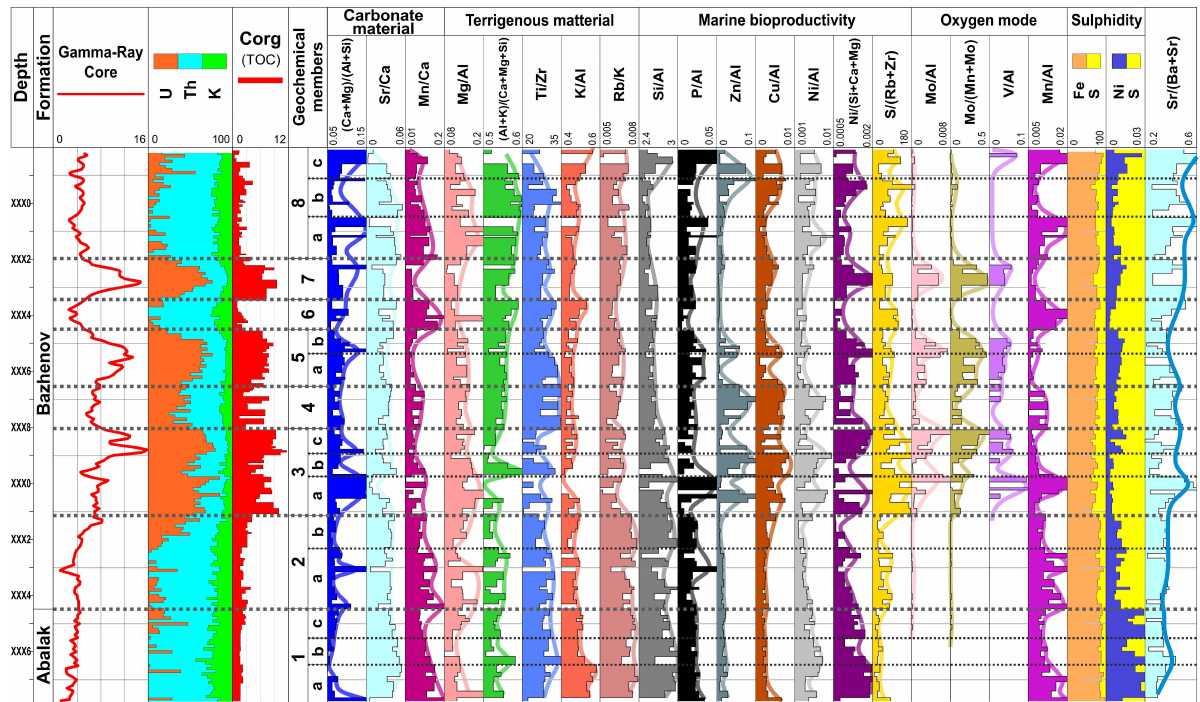
Figure 4. Geochemical structure of the section and variability of the values for geochemical